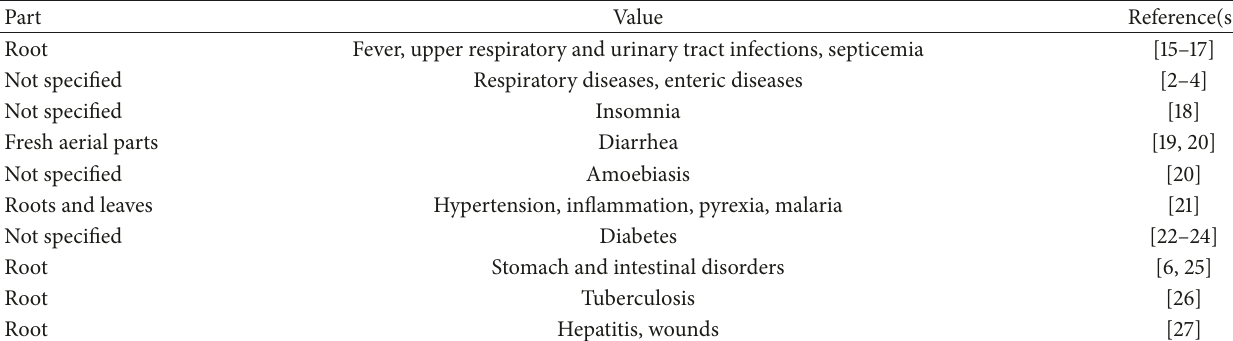
Table 1: Ethnopharmacological use of Cryptolepis sanguinolenta .